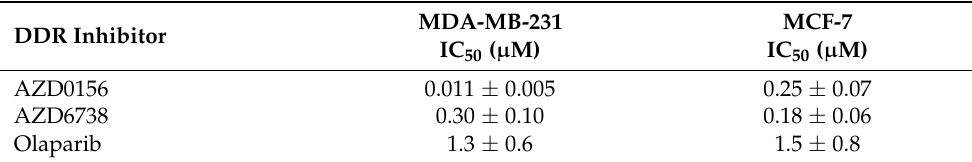
Table 1. IC 50 (µM) of AZD0156, AZD6738, and olaparib in MDA-MB-231 and MCF-7 cells as determined by clonogenic assays. IC 50 values were estimated from the plotted dose-response curves (not shown). Data are shown as mean ± SD of three independent experiments performed in duplicate wells.